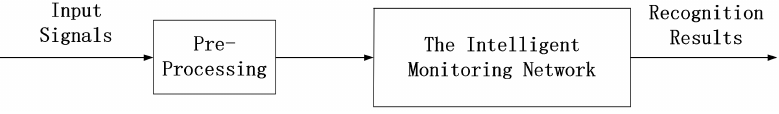
Figure 2. The flow chart of the algorithm.